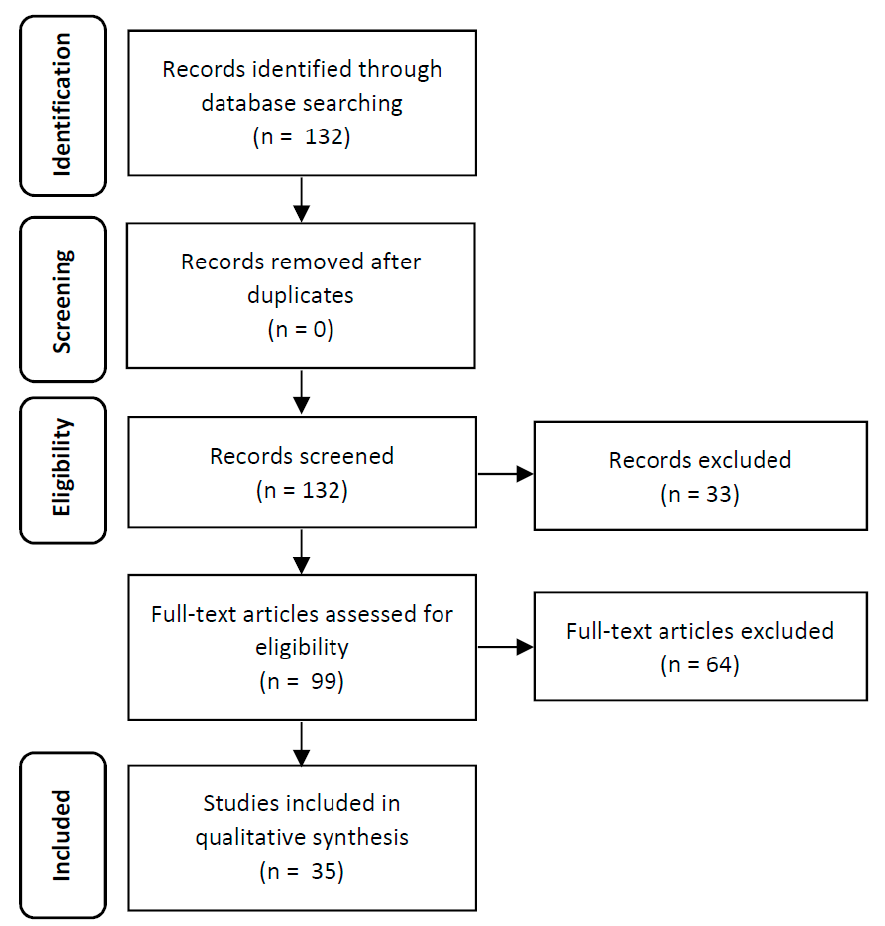
Figure 1. PRISMA flow diagram showing results of the literature search.